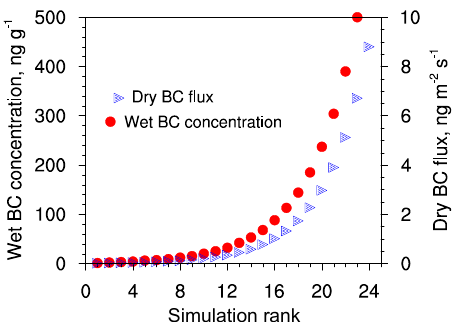
Figure 1. Prescribed values of BC concentrations in precipitation (red) and dry deposition fluxes (blue) applied in the CESM model- ing studies. Spacing between values is logarithmic.